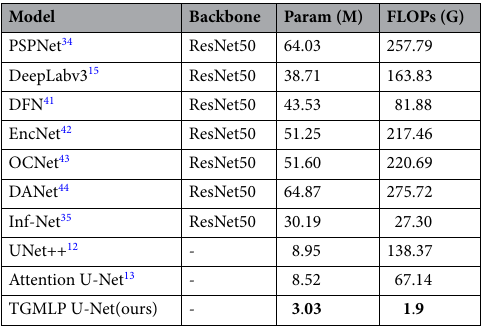
Table 2. Shows the comparison of Param, FLOPs on COVID-19 DataSet. The best values of each indicator are in bold. (“-” indicates that the model does not use the classical deep learning network as the backbone network.)